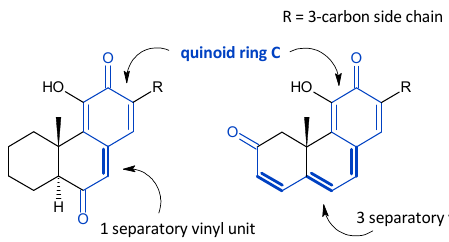
Figure 5. Skeleton of vinylogous quinones.